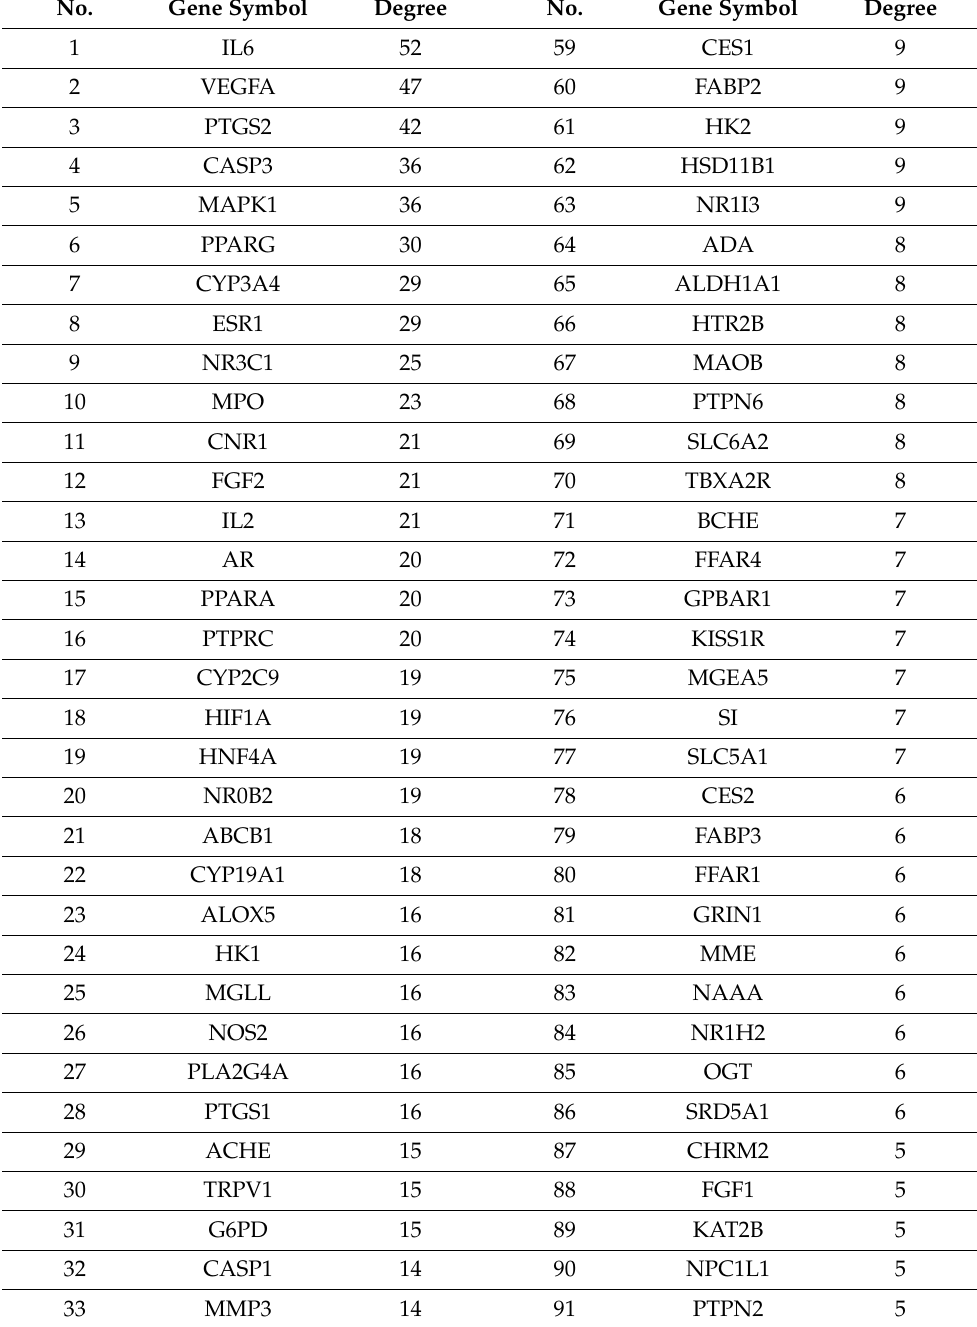
Table 3. The degree value of 116